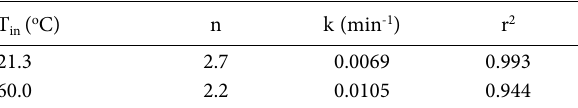
Table 1. Kinetic parameters derived from the fit with the Johnson- Mehl-Avrami-Kolmogorov model, including the Avrami exponent, n , the Avrami rate constant, k, and Pearson’s adjusted correlation coefficient, r 2 , for DI water with different initial temperatures, T in